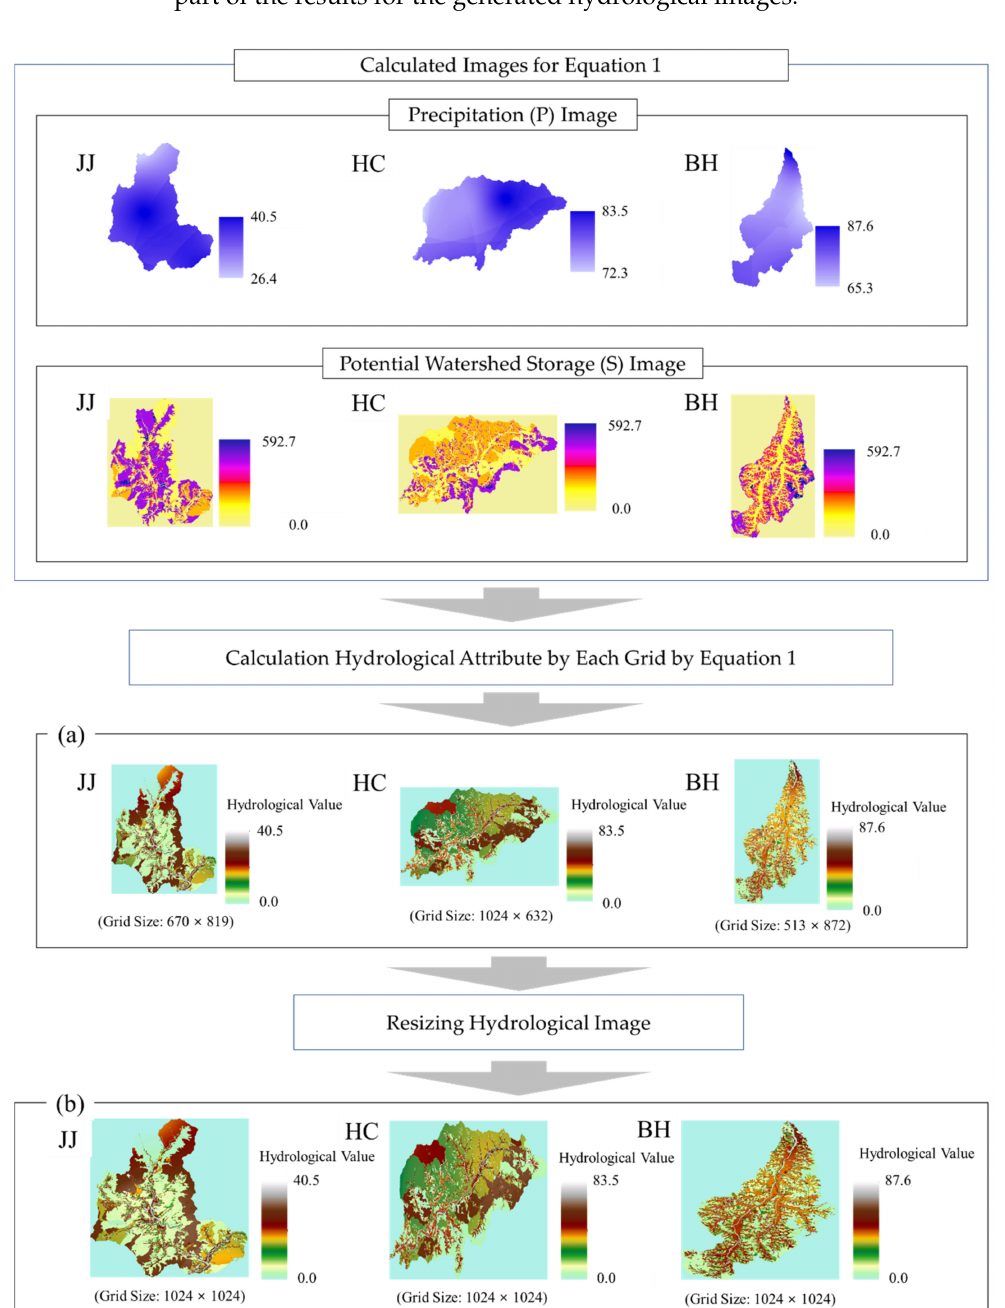
Figure 8. Scheme of generating hydrological images and resized hydrological images: ( a ) the initial generated hydrological images of the JJ (left), HC (middle), and BH (right) watersheds; ( b ) the resized hydrological images for the JJ (left), HC (middle), and BH (right) watershed at a grid size of 1024 ×